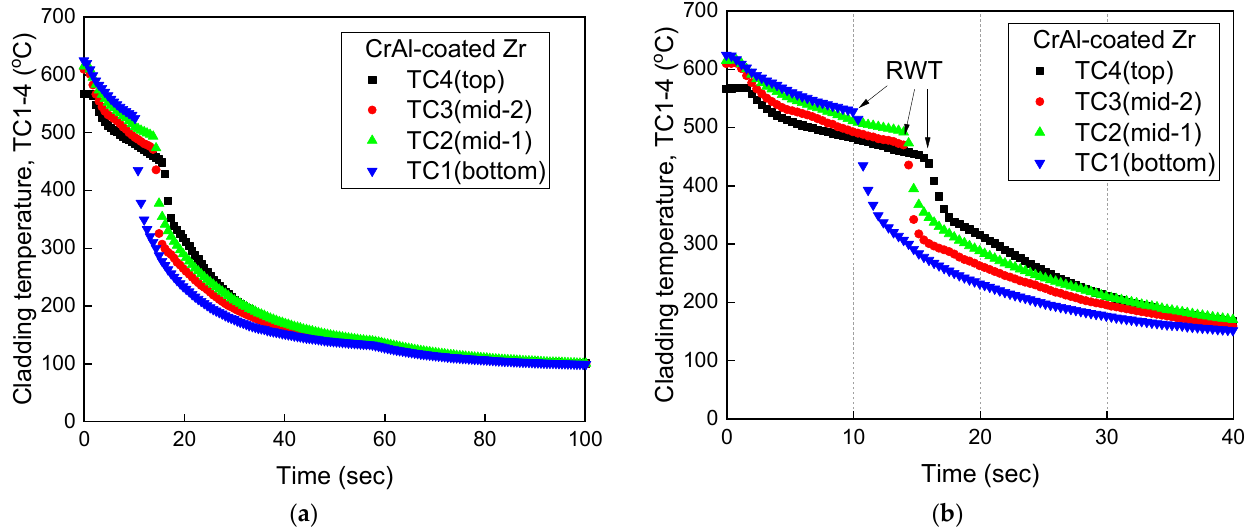
Figure 11. Quenching curve of the CrAl-coated Zr cladding at Tw = 600 °C, T sub = 5 °C and Vc = 0.05 m/s; ( a ) overview; ( b ) zoom in view.